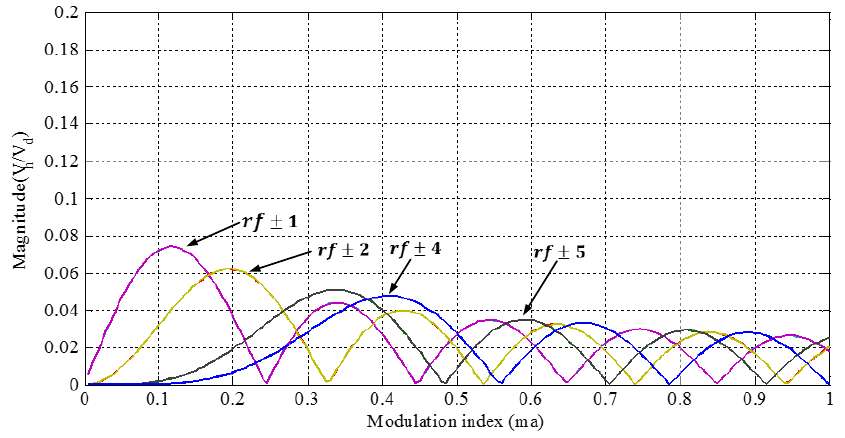
Figure 12. NLM harmonic distribution according to m a .